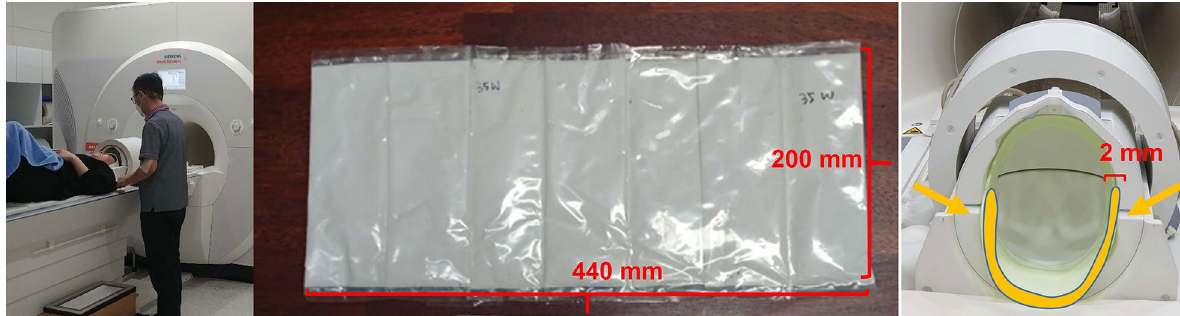
Fig. 1 Photograph of experimental method, shape and position of high‑dielectric pad (orange